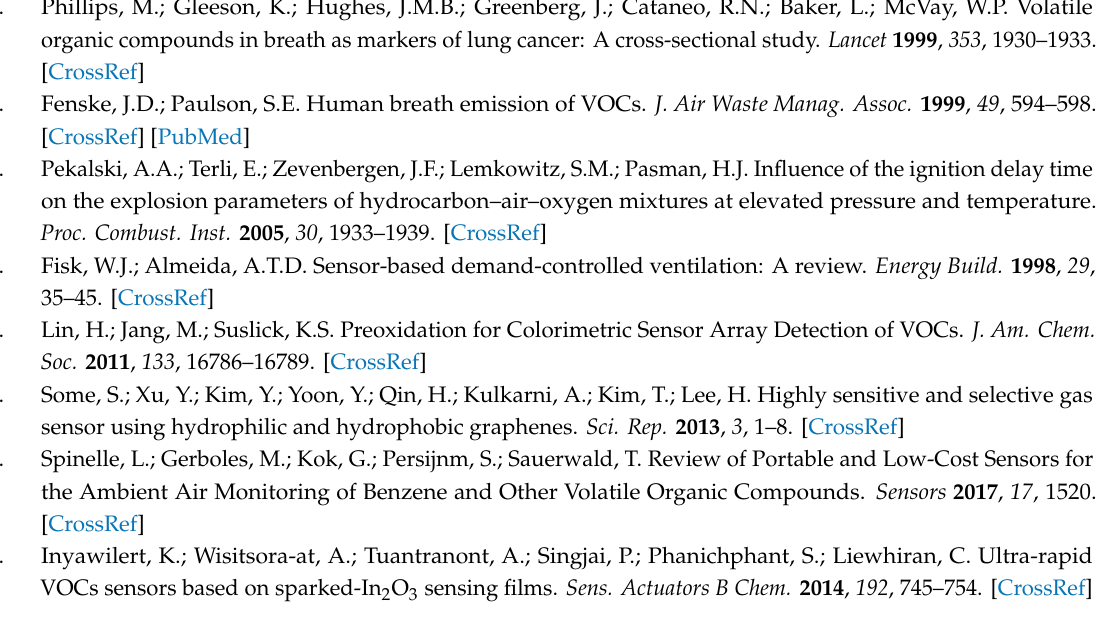
Figure S1: Photo of blade coating and sensor film, Figure S2: G / PPG HC sensor films thickness variation with error bar at dropped gasoline, Figure S3: sensitivity of (a) G / PPG (2:1) and (b) G / PPG (1:1) HC films at di ff erent liquid organic compounds and water, Figure S4: Photograph and mechanical stability of the G:PPG HC films on the PET film, Figure S5: (a)—(d) Sensitivity of G / PPG (1:2) HC film with various liquid organic compounds Figure S6: Swelling phenomenon of (a) G / PPG (1:1) HC, (b) G / PPG (2:1) HC and (c) Graphite film with gasoline, Table S1 Zeta potential analysis of pure Graphite, G / PPG (2:1), G / PPG (1:1), and G / PPG (2:1) HC pastes, Video S1: Video of measure to resistance the fabricated G / PPG sensor with non-woven fabric, Video S2: Video of swelling phenomenon taken by contact